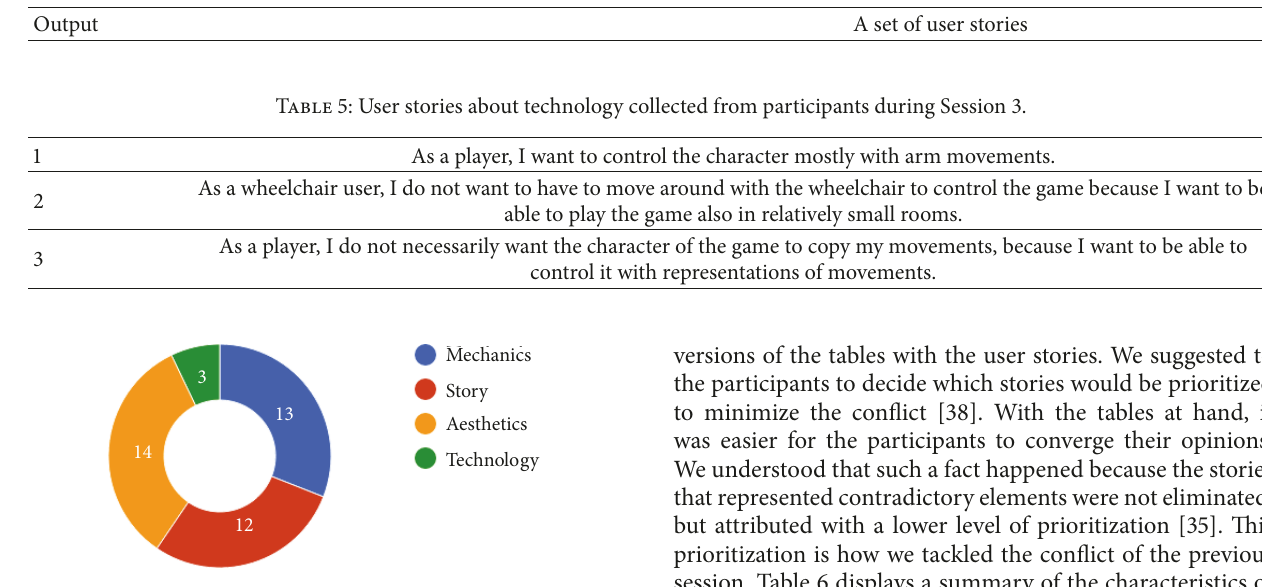
Figure 3: Number of suggested user stories by basic elements of games